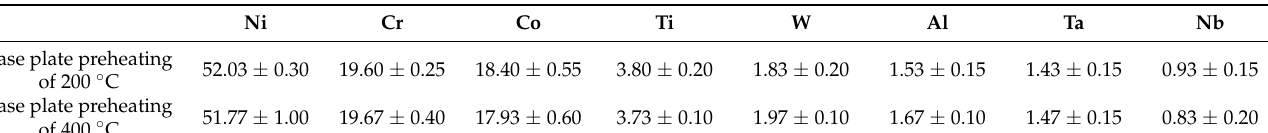
Table 3. Chemical composition of IN939 unfused powder used at 200 °C and 400 °C preheating temperatures measured using EDX in weight percentage (wt. %).